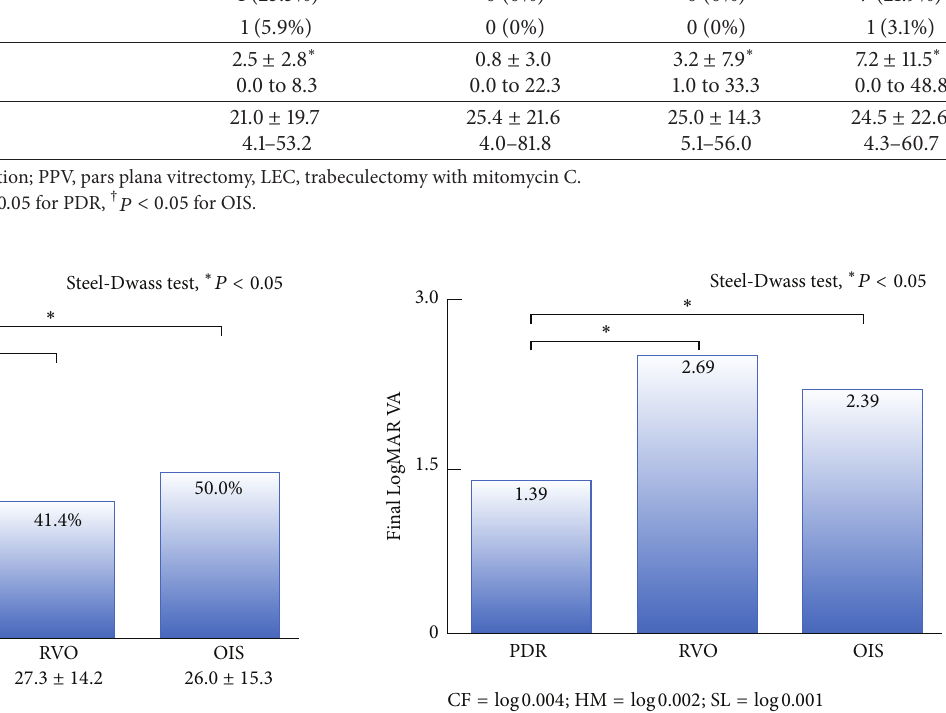
Figure 3: Final LogMAR VA values according to NVG